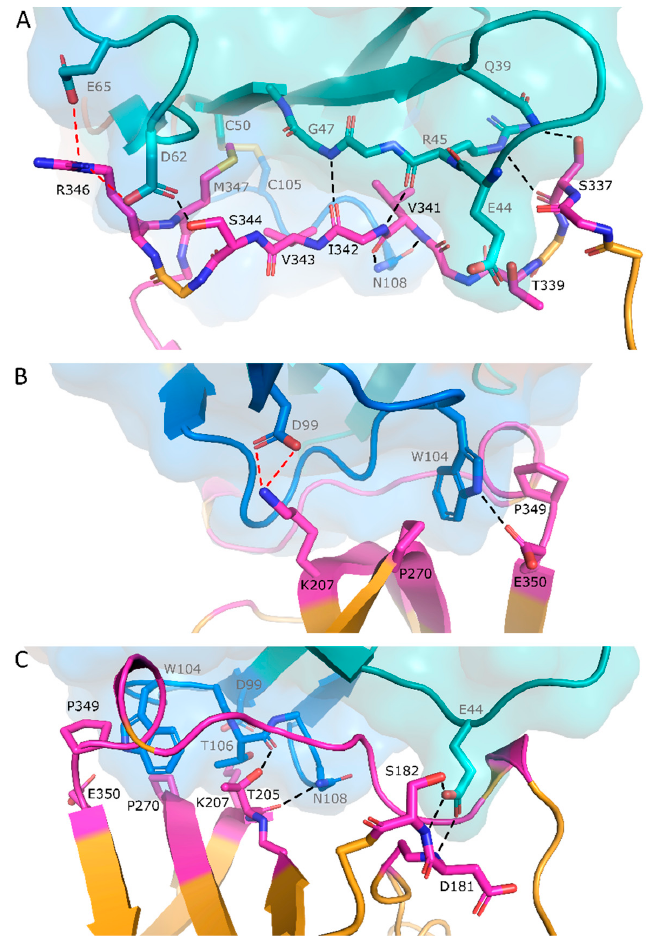
Figure 2. Interaction interface between PAI-1 and Nb93. ( A ) Detail of the interaction between Nb93 and the RCL of PAI-1; ( B , C ) Detail of the interaction between Nb93 and residues located in the direct environment of the RCL of PAI-1. PAI-1 is colored orange, with residues closer than 4 Å to Nb93 in magenta. Framework regions of Nb93 are in teal; CDR1, CDR2, and CDR3 are in yellow, brown, and blue, respectively. Hydrogen bonds are indicated by black dotted lines; salt bridges are indicated by red dotted lines.